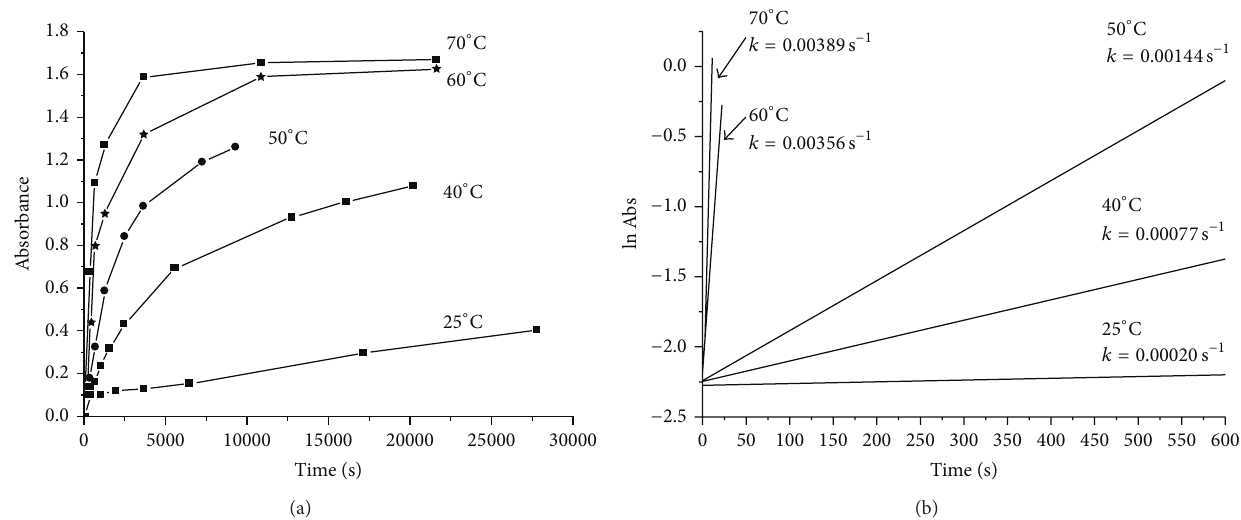
Figure 7: The formation kinetics of the Cr-EDTA complex at different temperatures (a) and the linearization of the equation speed (ln [Abs] = 𝑘𝑡 ) with the respective constants